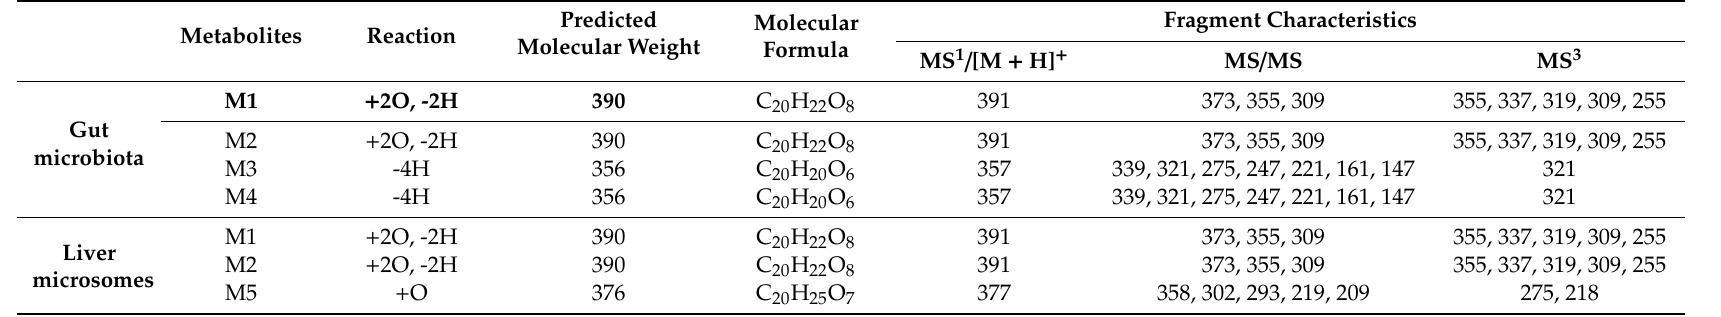
Table 1. Characteristics of triptolide metabolites in gut microbiota and liver microsomes by LC / MS n